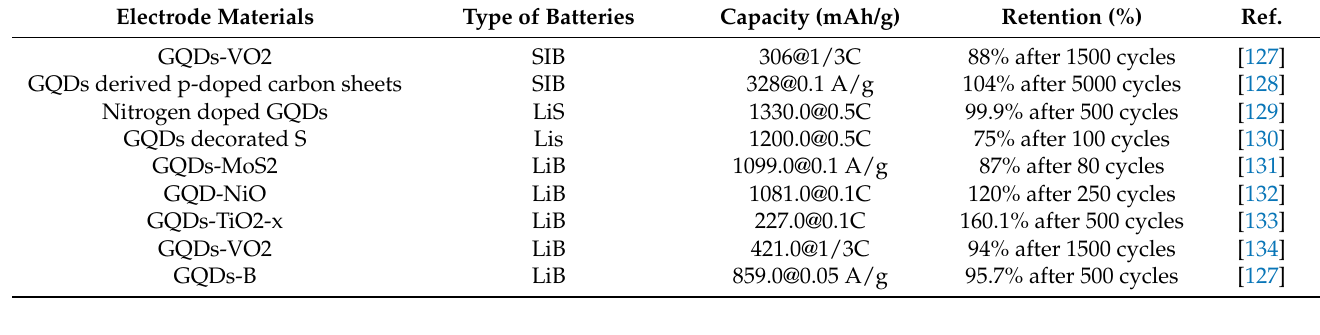
Table 2. Electrochemical performances of the GQD-based battery electrodes.